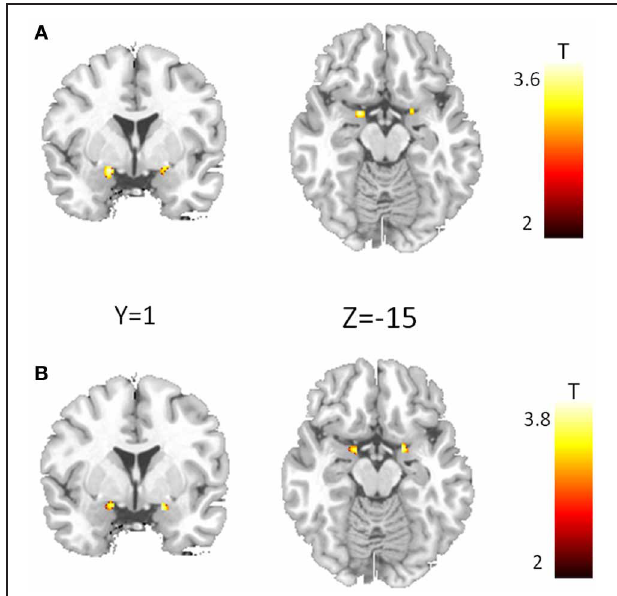
FIGURE 2 | Epistasis effect between CD38 and COMT in the amygdala. (A) Voxel showing a significant three-way interaction between CD38, COMT, and substance. (B) Interaction between CD38 and COMT for the placebo condition. ( p < 0 . 05, FWE corrected for the region of